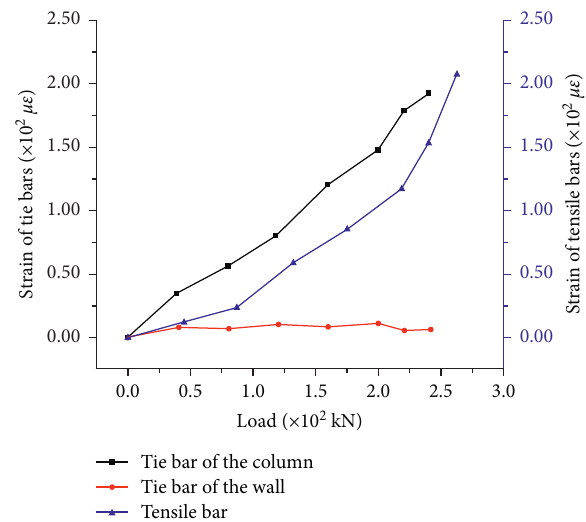
Figure 9: The strain-load curves of the